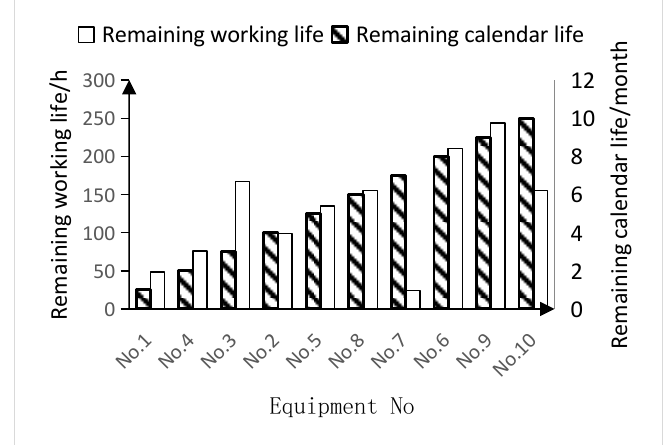
Figure 1. Two life echelon usage.